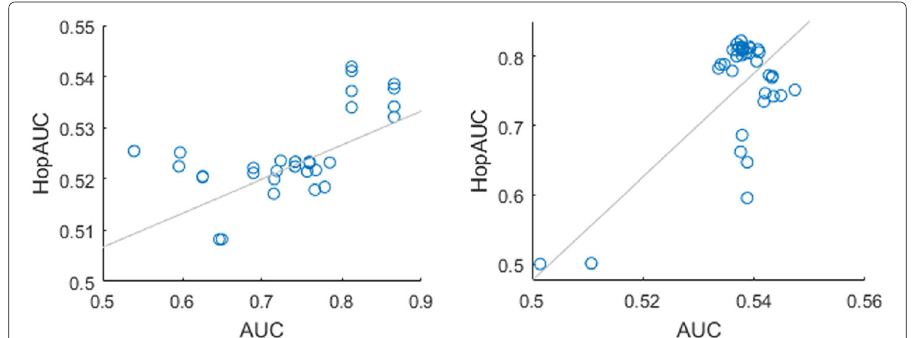
Fig. 10 Scatterplots and least square lines between AUC and HopAUC for the BlockModel with 0.1% example nodes (left) and CiteSeer with 0.1% example nodes (right). Each point corresponds to a different ranking